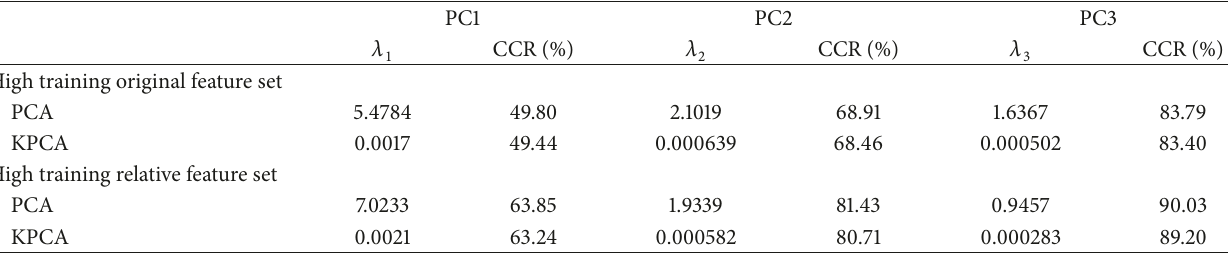
Table 3: PCA and KPCA